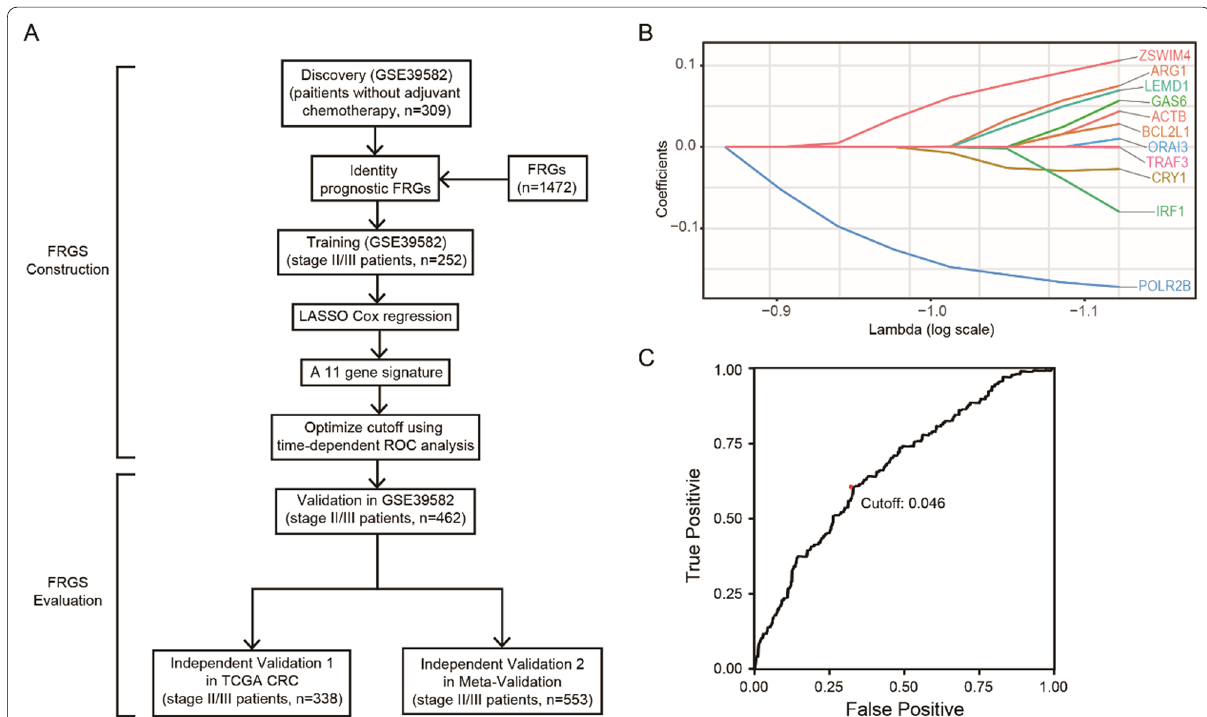
Fig. 1 Establishment and verification of FRGS. A Schematic flow chart of study design. B A total of 11 fibroblast‑related genes selected in LASSO Cox regression. C The optimal cut‑off obtained at 5‑year in time‑dependent ROC curve analysis